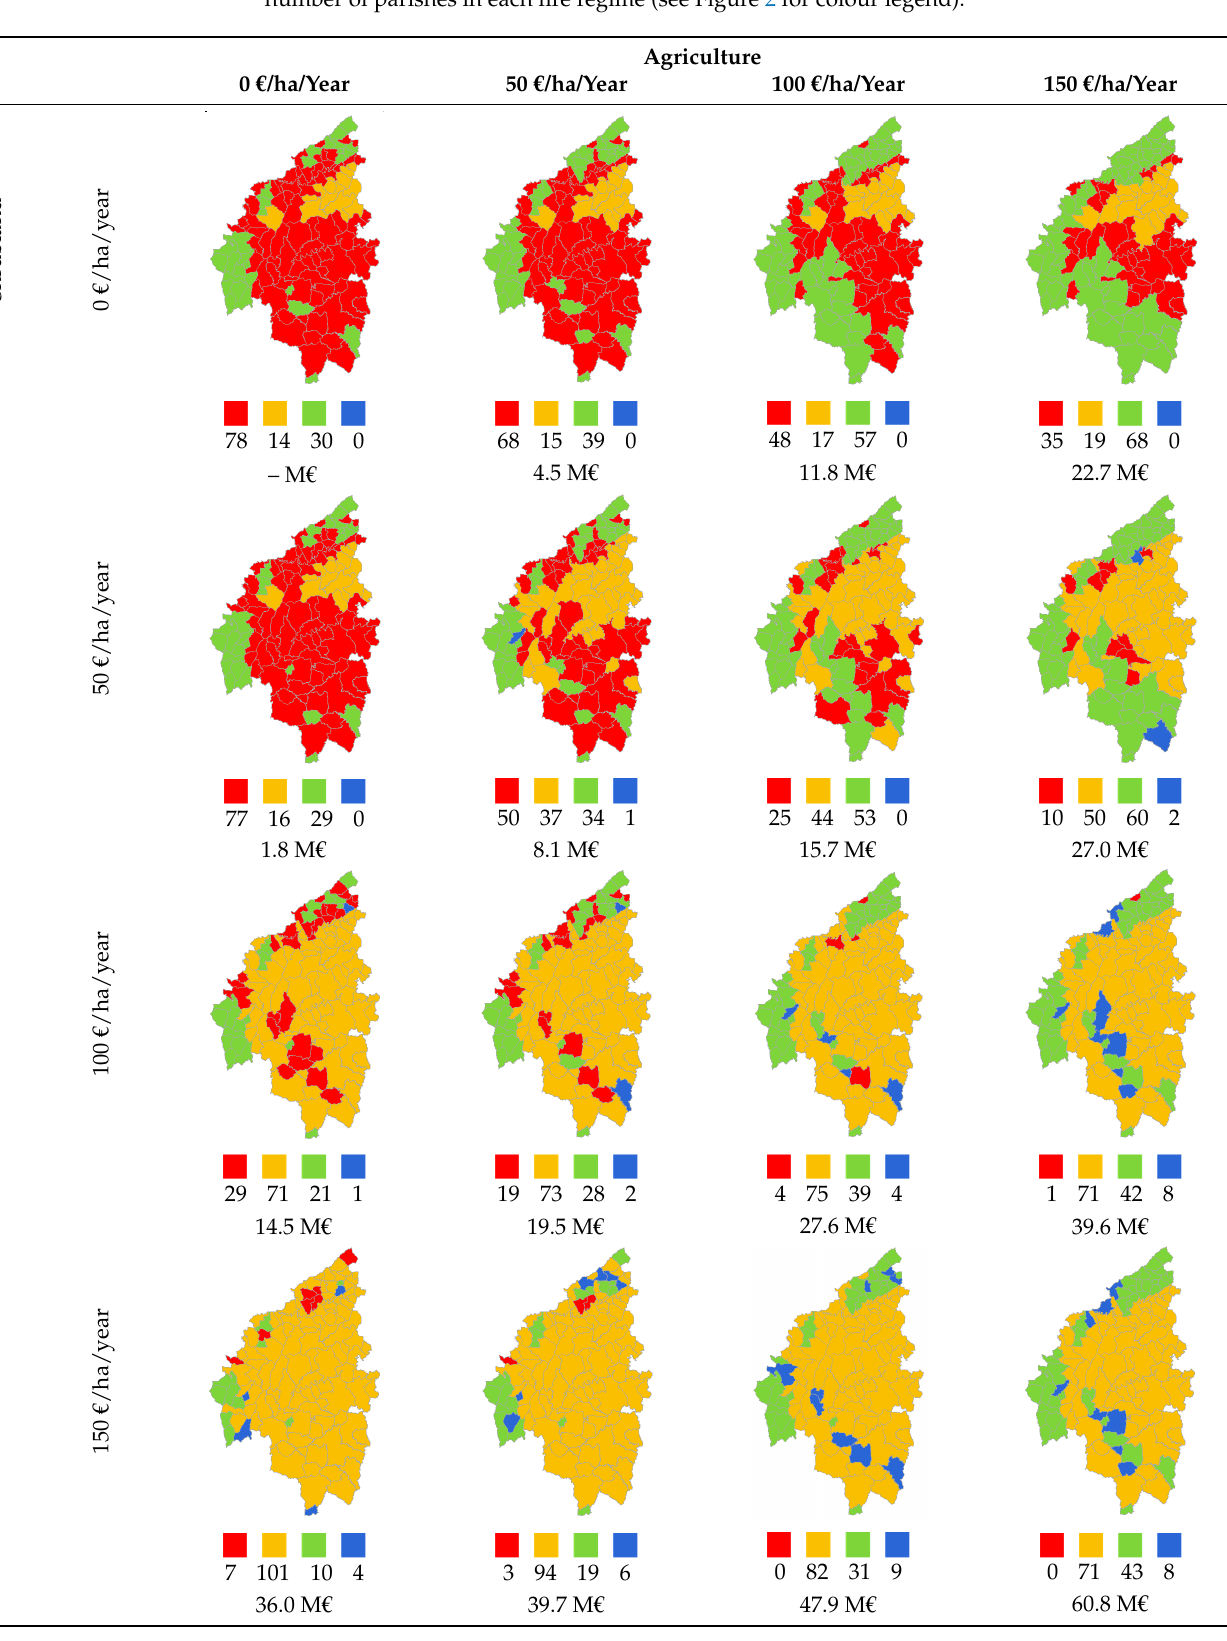
Table 3. Fire regime outcomes in each scenario and estimation of the total annual cost of the measure in 10 6 euros (M€). Polygons identify parishes. The numbers below the coloured symbols identify the number of parishes in each fire regime (see Figure 2 for colour legend).